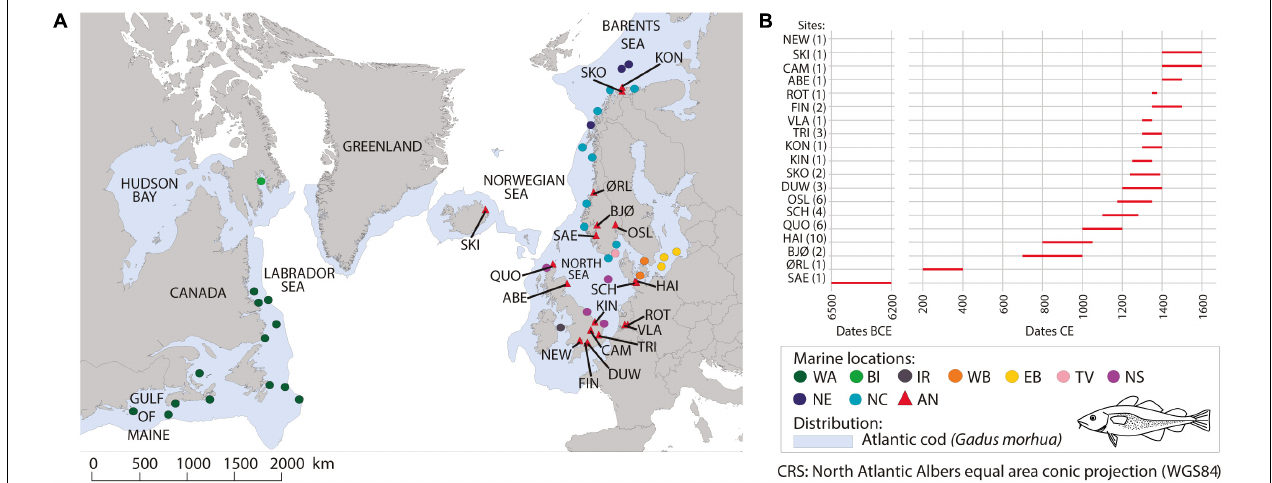
FIGURE 1 | (A) Ancient and modern Atlantic cod sampling locations. The abbreviated name of archeological sites is shown in the map (see also Supplementary Table 1 ). Modern data were obtained from Jørgensen et al. (2018); Lait et al. (2018) and Barth et al. (2019). Sample sites are grouped according to larger oceanographic location, ecotype and modern or ancient specimens: western Atlantic (WA) = dark green, Baffin Island (BI) = light green, Irish Sea (IS) = gray, North Sea (NS) = purple, western Baltic (WB) = orange, eastern Baltic (EB) = yellow, Tvedestrand fjord (TV) = pink, North East Arctic (NE) = dark blue, Norwegian coast (NC) = blue, and Ancient specimens (AN) = red (i.e., Saevarhelleren = SAE, Ørland Kampflybase = ØRL, Bjørkum = BJØ, Haithabu = HAI, Quoygrew = QUO, Schleswig Schild = SCH, Oslo Mindets Tomt = OSL, Bristol Dundas Wharf = DUW, Skonsvika = SKO, King’s Lynn Raynham House = KIN, Kongshavn = KON, London Trig Lane = TRI, Vlaardingen Gat in de Markt = VLA, Bristol Finzel’s Reach = FIN, Rotterdam, Hoogstraat 13–26 = ROT, Aberdeen = ABE, Cambridge Grand Arcade = CAM, Skri ð uklaustur = SKI, Newport Ship = NEW). Modern distribution of Atlantic cod is shown in light blue. Fish illustration drawn by Geir Holm. (B) Cleveland plot showing the age range of ancient samples. Sample age is estimated based on archeological context. The number of individuals per site is represented in brackets after the site name ( Supplementary Table 1